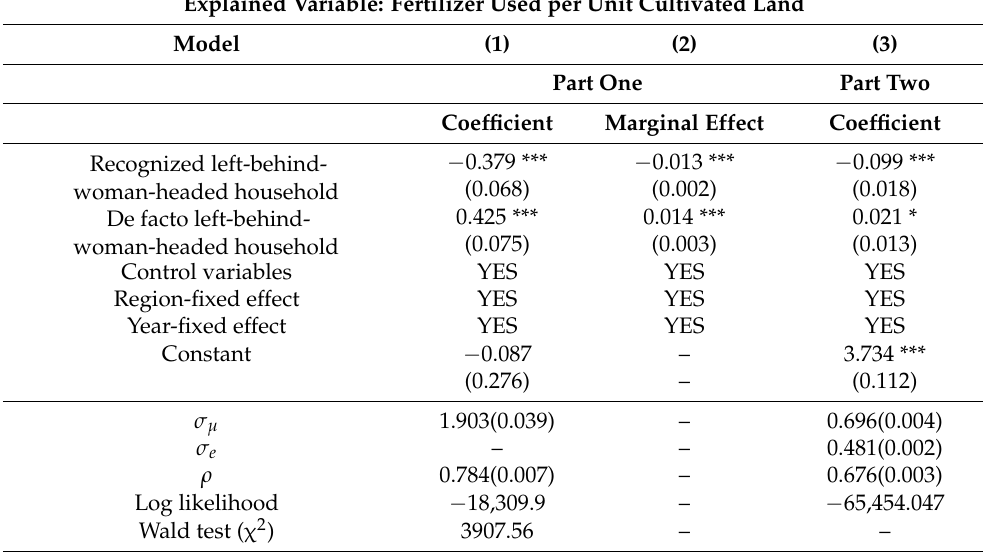
Table 3. Results of robustness test: two-part model. Explained Variable: Fertilizer Used per Unit Cultivated